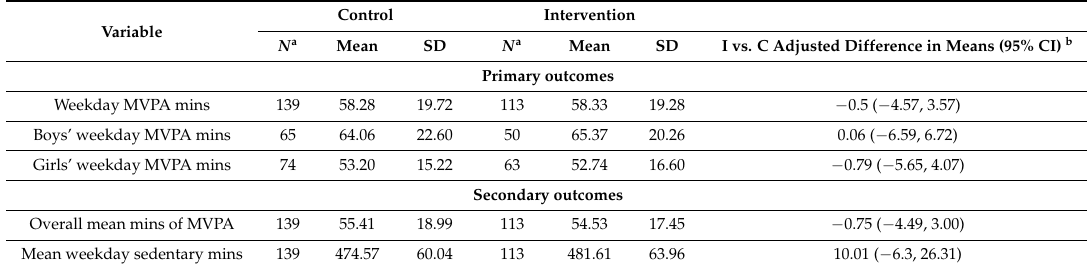
Table 1. Physical activity and sedentary time at T1 by trial arm.